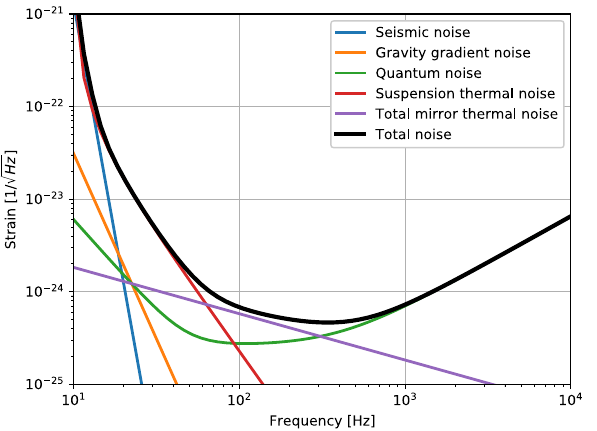
Figure 5. Estimated sensitivity of the 3-D